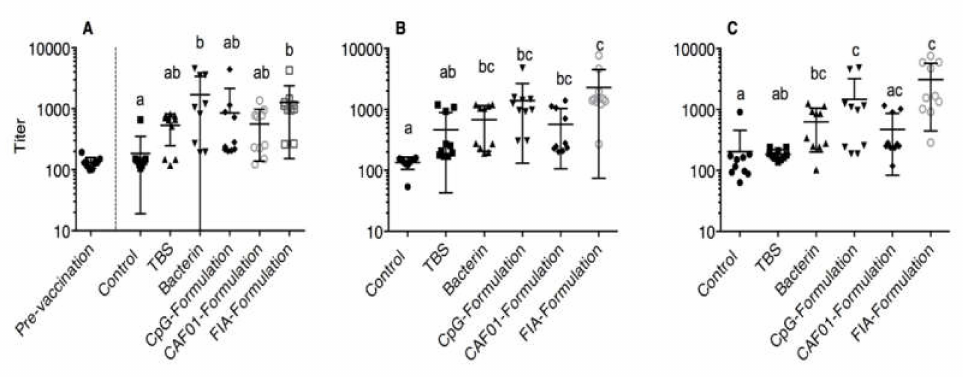
Figure 1. Scatter Dot-Plots of mean ELISA titers ± SD for each experimental group. For details on titer calculation, see the Materials and Methods section. ( A ) Three weeks post vaccination: the pre-vaccination values are shown as a point of reference and are not included in the statistical analysis. ( B ) Six weeks post vaccination. ( C ) Ten weeks post vaccination. Group titers at each time point were compared by Kruskal–Wallis, followed by Dunn’s post test. Statistically significant di ff erences are denoted using lower case letters. Identical letters indicate P > 0.05, di ff erent letters indicate P <